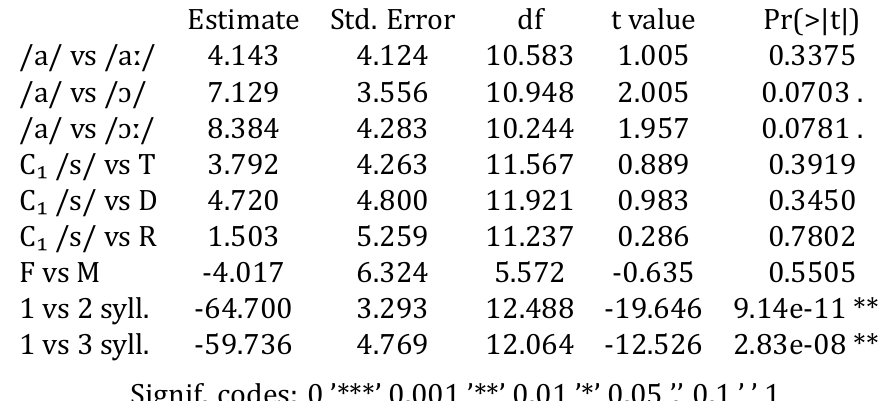
Table A.17: Release duration (ms) of C₂ fortis plosive as a dependent